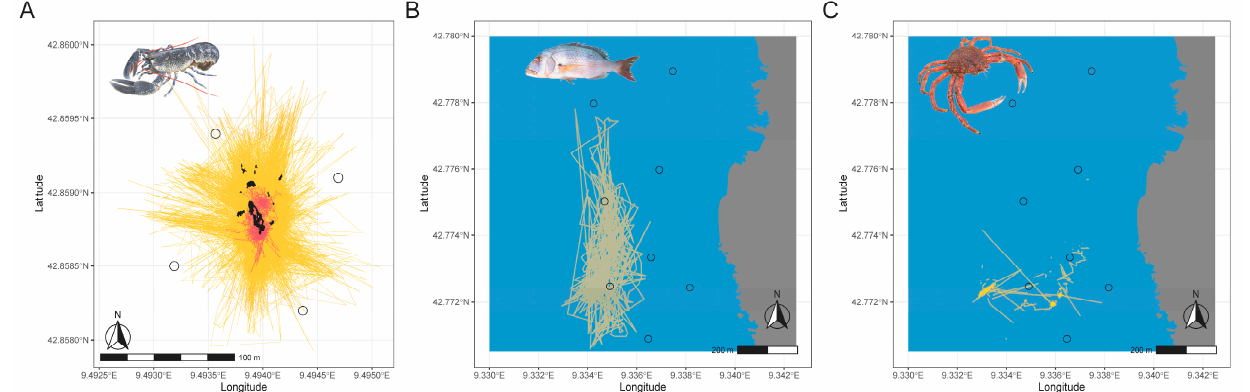
Figure 11. ( A ) A continuous-time correlated random walk model (CTCRW) is applied to raw TDOA data (yellow) to reveal more realistic movement paths (red) of a lobster tagged with a continuous pinger released at a wreck (black shape); ( B ) movement paths of an individual tagged dentex; ( C ) a spider crab in Nonza after applying the CTCRW model. The black circles correspond to the positions of the buoys of the real-time tracking